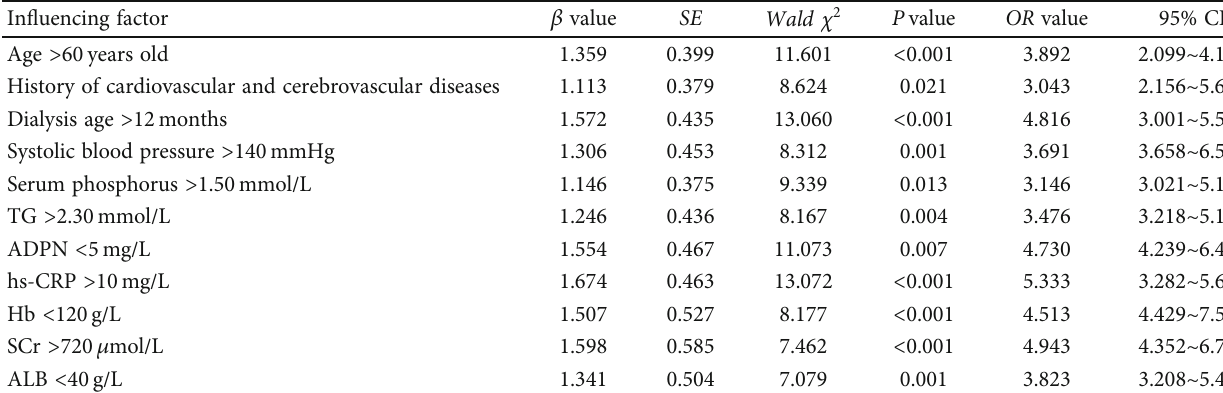
Table 2: Multivariate logistic regression